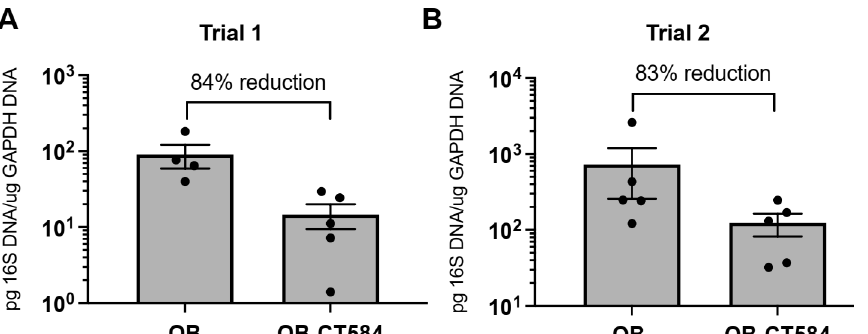
Figure 6. Pre-incubation of C. trachomatis with immune serum from Q β -CT584-vaccinated mice reduces infection in the upper genital tract. C. trachomatis were pre-opsonized in vitro with heat- inactivated serum pooled from mice immunized with Q β -CT584 or Q β alone, immediately prior to transcervical inoculation into the upper genital tract of naïve female mice. Bacterial burden in the upper genital tract was measured by qPCR. Data are presented from independent pre-opsonization experiments using immune serum from two independent vaccine trials, Trial 1 (( A ), p = 0.0159) and Trial 2 (( B ), p = 0.095). Pre-incubation with Q β -CT584 serum resulted in a 83–84% reduction in bacterial burden compared to pre-incubation with negative control Q β serum. Horizontal lines represent means +/ −